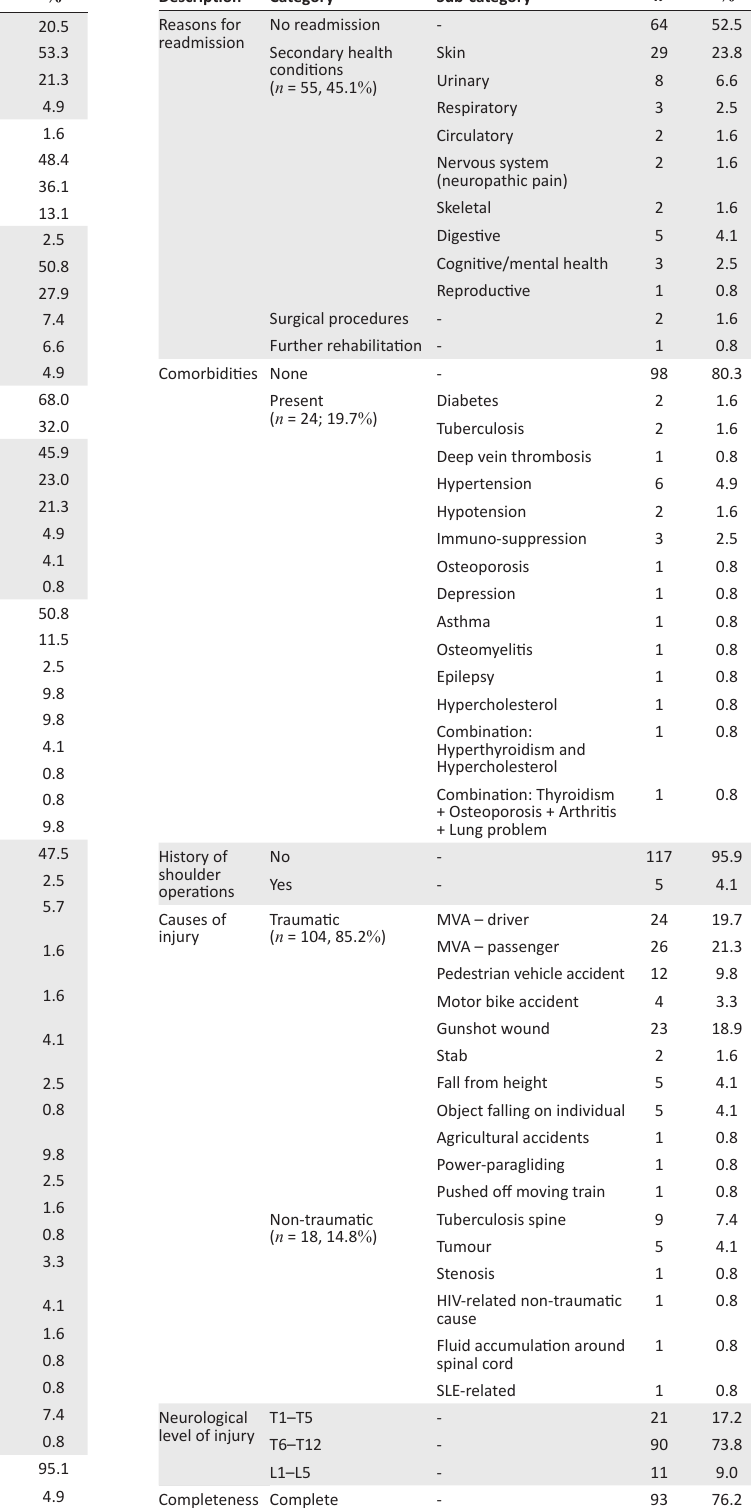
TABLE 1 (Continues...): Participants’ sociodemographic and injury profile ( n =